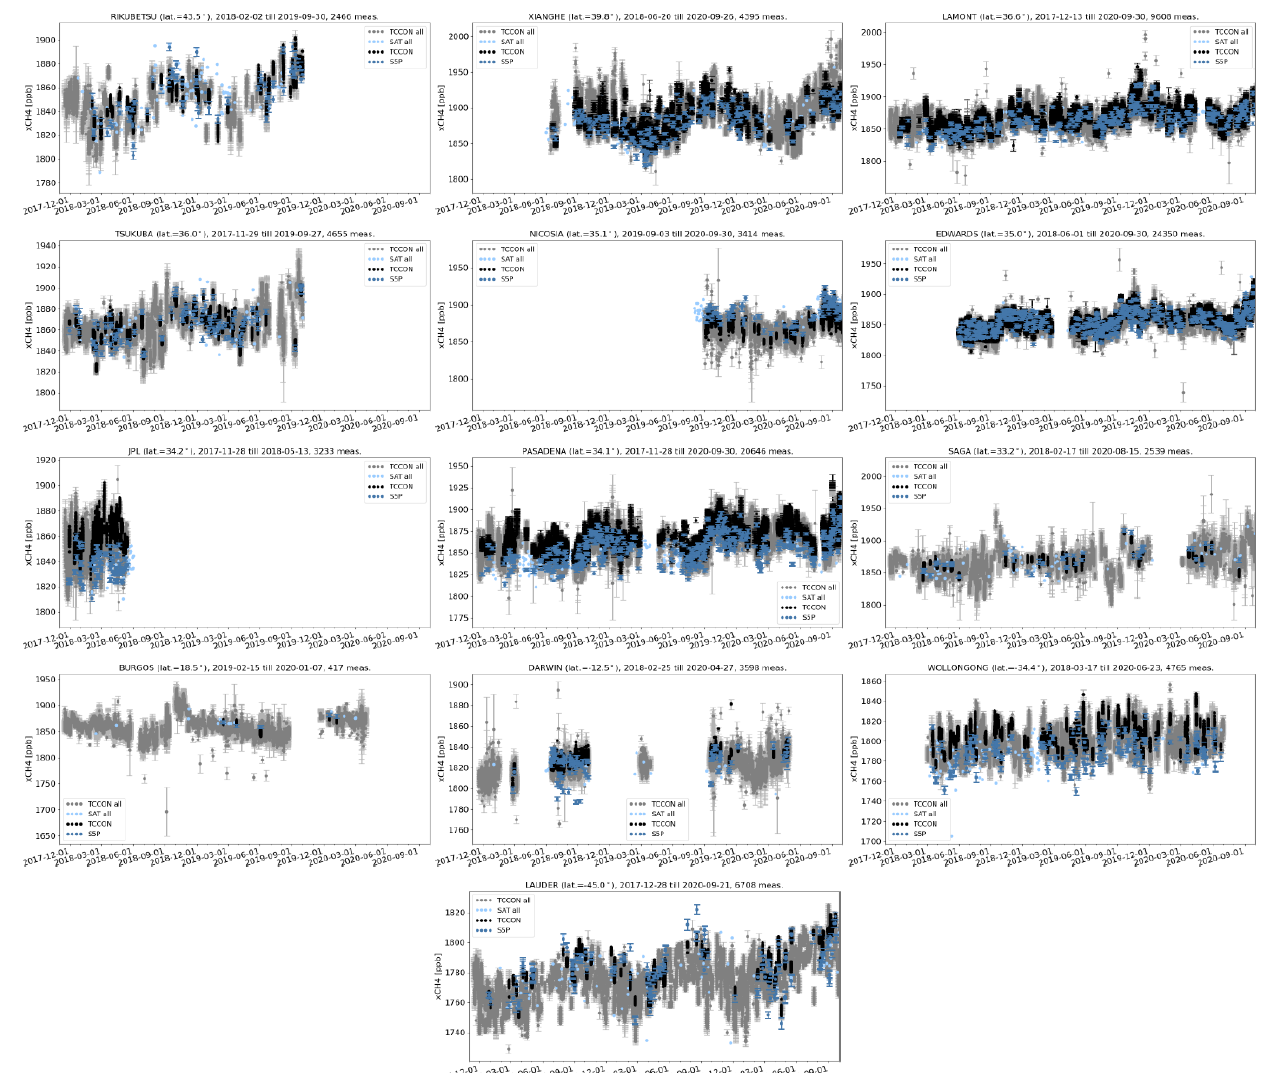
Figure 5. Same as Fig.